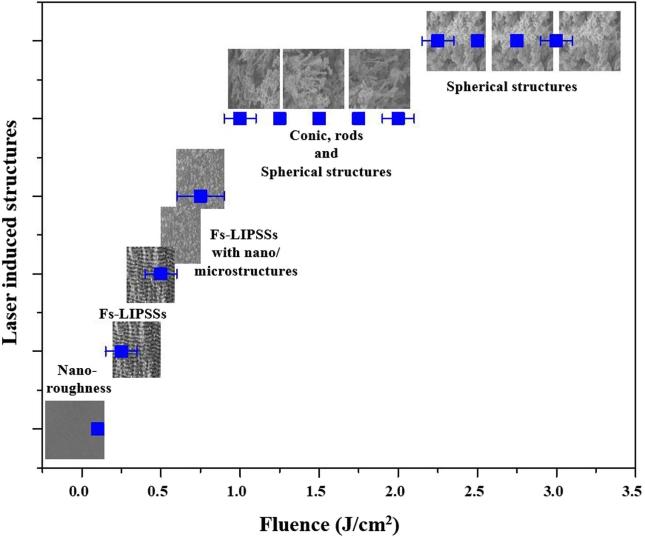
Laser-induced structural features as a function of laser fluence. The fluence range for each structural feature is estimated and error bars are calculated as the standard deviation in variation of fluence range.